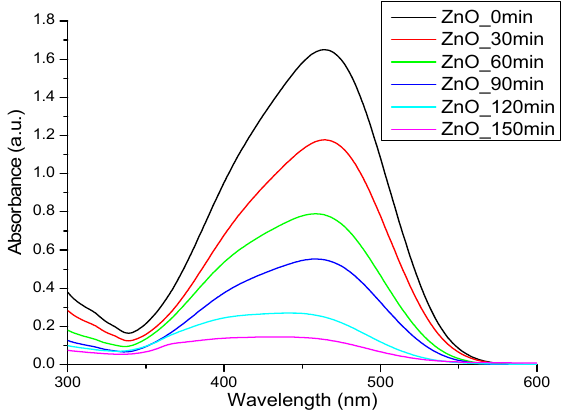
Figure 7. Photocatalytic activity against methyl orange (MO) for ZnO nanoparticles. For diluted solutions, the photodegradation reactions exhibit apparent first-order kinetics (Figure 8), ln(C0/C) = k app ·t (1) where C0 is the initial concentration of MO, C is the MO concentration at time t (min), and k app is the rate constant of the apparent first order.